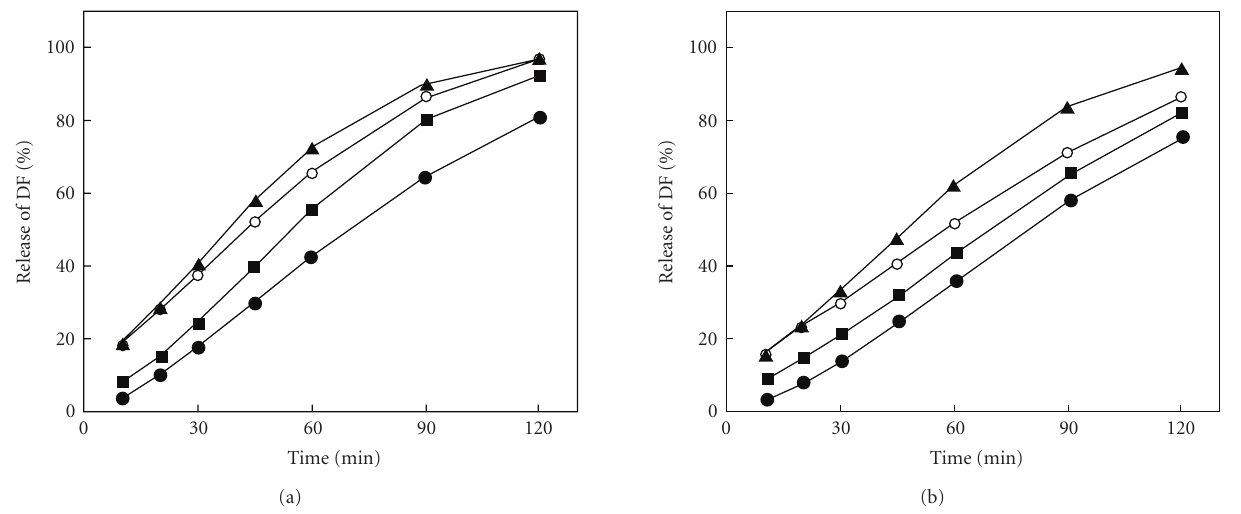
Figure 4: Release profiles of DF in physiological saline. (a) Prepared with 1.5% alginate and 0.1 M CaCl 2 . (b) Prepared with 2.0% alginate and 0.1 M CaCl 2 . Open circles: Alg-Ca; closed triangles: CAP (0.2% AP); closed squares: CAP (0.5% AP); closed circles: CAP (0.8%